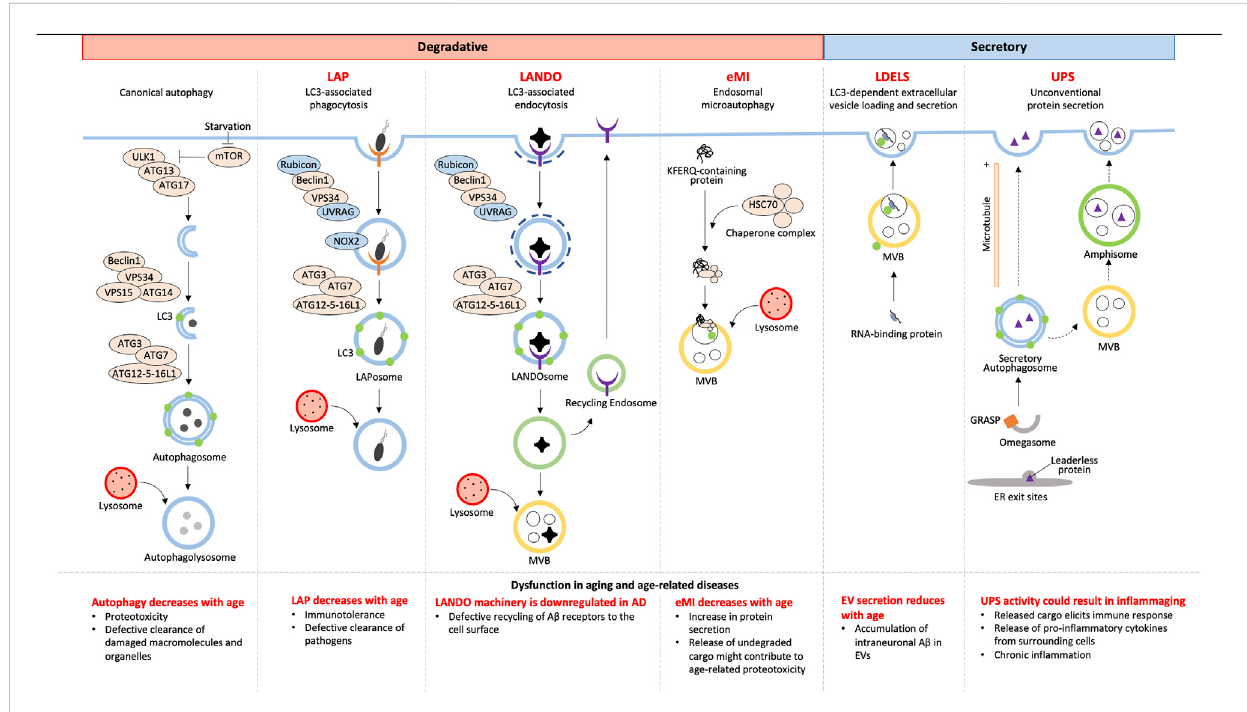
FIGURE 1 Overview of canonical and non-canonical autophagy and their dysfunctions in